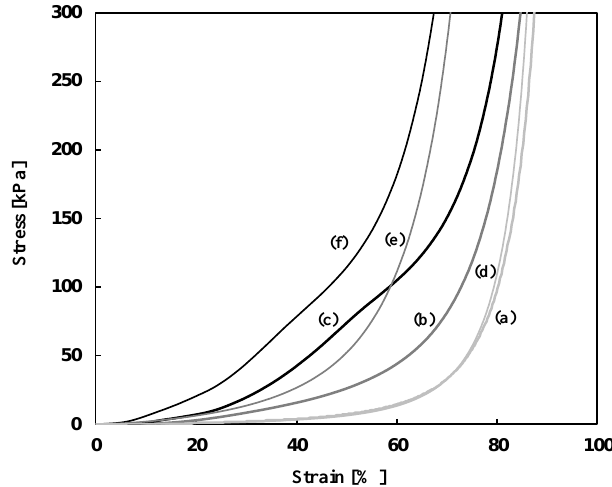
Figure 9. Stress–strain curves of PEI-PEGDA200 (bold lines: a – c ) and DETA-PEGDA200 (thin lines: d – f ) dry porous polymers; monomer concentration in the reaction system: ( a , d ) 20 wt %, ( b , e ) 25 wt %, and ( c , f ) 30 wt %; feed molar ratio of PEI/PEGDA200: 2/7 or DETA/PEGDA200: 2/5 Case 2).